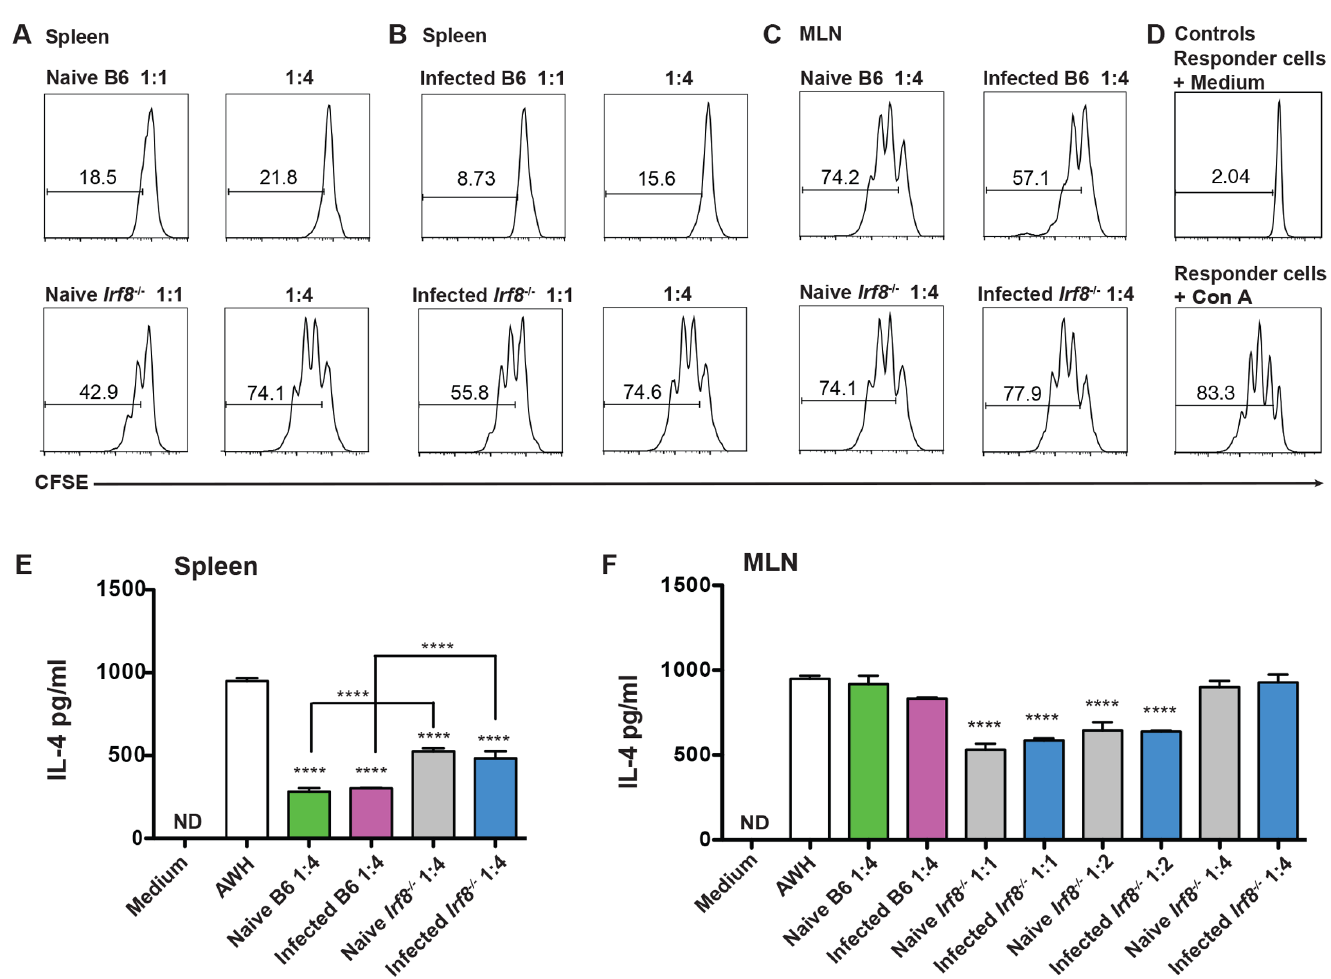
Fig 4. CD4 + T cells are suppressed by MDSC from na ï veor Hpb-infected C57BL/6 and Irf8 -/- mice. Purified CD11b + Gr1 + cells from spleenof na ï ve (A) and infected (B) C57BL/6(B6) or Irf8 -/- mice were co-cultured with CFSE-labeledspleencells from na ï veB6 mice and stimulatedwith 2 μ g/ml Con A. (C) Purified CD11b + Gr1 + cells from MLN of na ï veor infected C57BL/6(B6) and Irf8 -/- mice were co-culturedwith CFSE-labeled spleen cells from na ï veB6 mice and stimulatedwith 2 μ g/ml Con A. (D) Controlcultures containingresponder cells alone (top) or respondercells stimulatedwith 2 μ g/ml Con A (bottom). CFSE dilutionin panelsA-D was analyzedin gated CD4 + T cells by flow cytometry. The data shown are representativeof two replicate experiments. Purified CD11b + Gr1 + cells from spleens(E) or MLN (F) of na ï veor infected B6 and Irf8 -/- mice were co-culturedwith spleen cells from infected B6 mice and stimulatedwith medium or 50 μ g AWH. IL-4 levels were determined in 48 h supernatants by ELISA. The ratio of MDSC:responder cells is indicatedfor each panel. The data shown are representativeof two to three replicateexperiments and are presented as mean ± SEM. ND, not detectable; **** , p (cid:20)